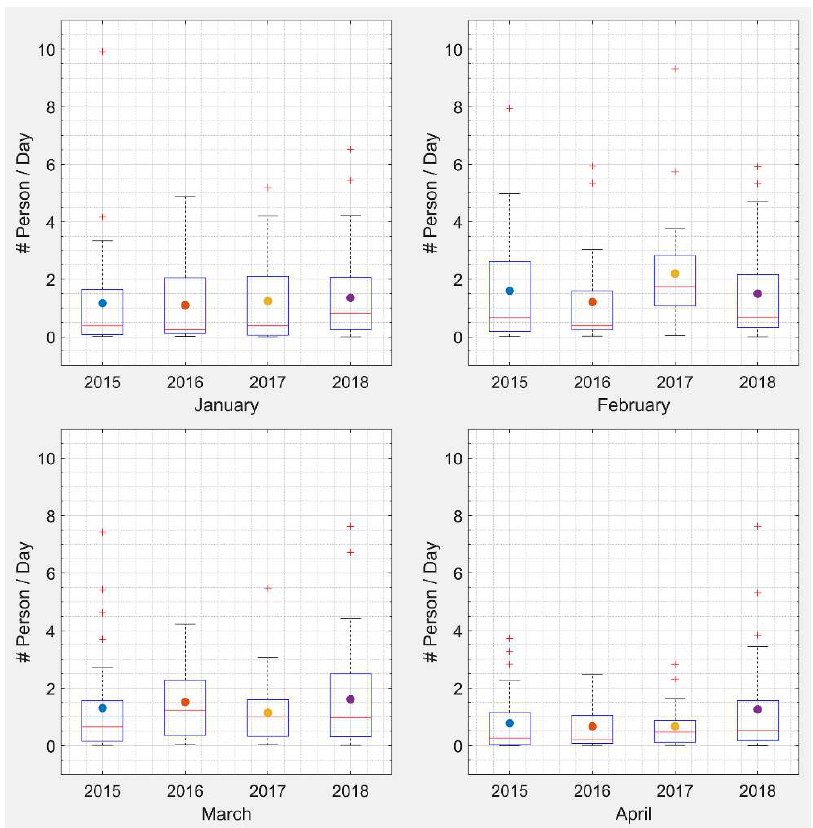
Figure 6. Estimated daily asthma-related ER visits in Georgia due to prescribed burning for January–April of each year from 2015 to 2018. The central mark indicates the median, the point indicates the mean, and the bottom and top edges of the box indicate the 25th and 75th percentiles, respectively. The whiskers bound the range of values excluding the outliers.